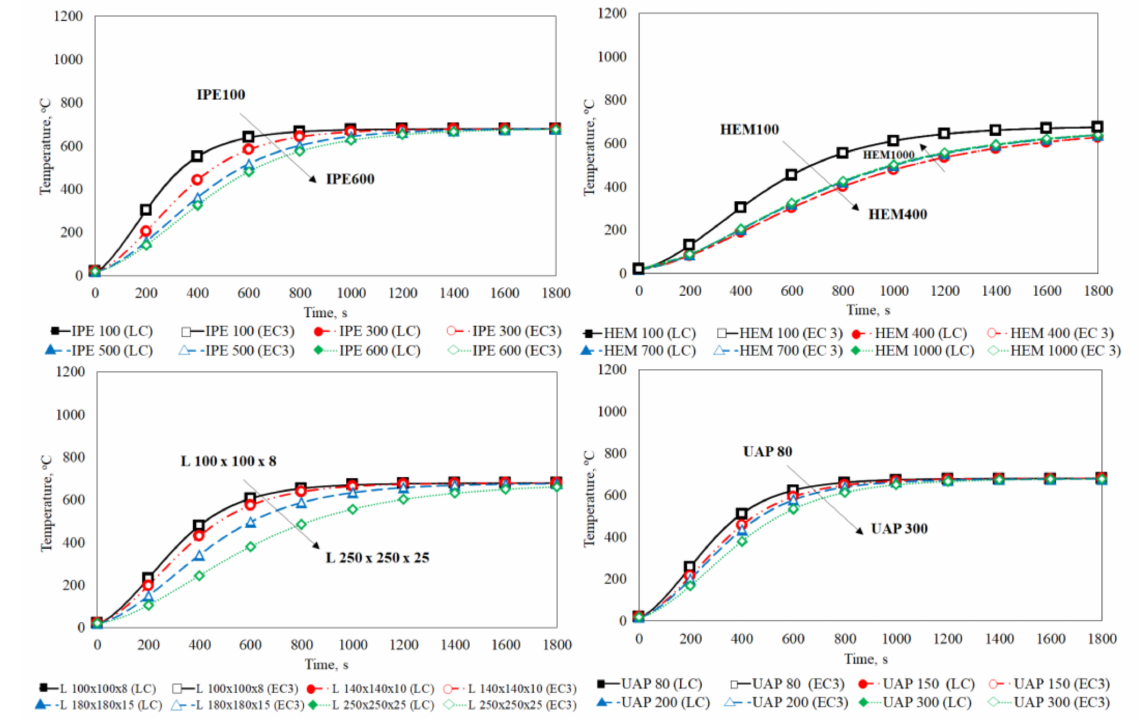
Figure 8. Temperature–time history of different profiles under external curve. LC and EC3 are in agreement.